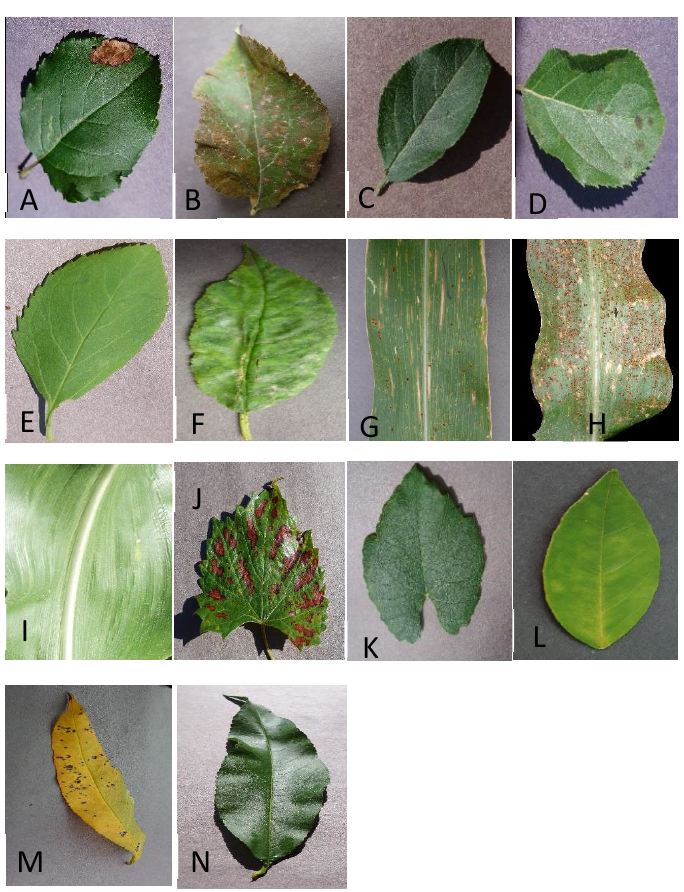
Figure 1. Sample images of the dataset. ( A ) apple black rot, ( B ) apple cedar rust, ( C ) apple healthy, ( D ) apple scrab, ( E ) cherry healthy, ( F ) cherry powdery mildew, ( G ) corn grey leaf spot, ( H ) corn common rust, ( I ) corn healthy, ( J ) grapevine measles, ( K ) grapevine healthy, ( L ) orange huanglongbing, ( M ) peach bacterial spot, ( N ) peach healthy.